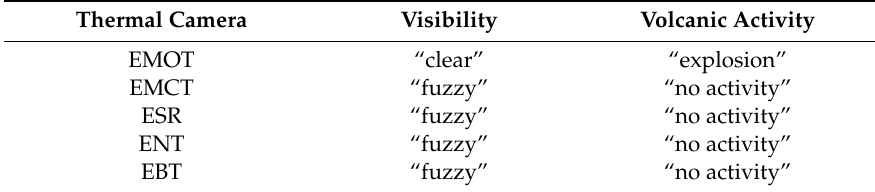
Figure 6. Raw images as acquired on 9 September, 2019 at 18:58:20 UTC by EMCT ( a ), EMOT ( b ), ESR ( c ), EBT ( d ) and ENT ( e ). The ESR camera has a lower frame rate than the others, i.e., 2 fps; for this case, the ESR image closer to the other cameras is shown. The monitored scene shows the Strombolian activity which started on the first half of September and was only just detected because of the low visibility conditions. Table 5. Algorithm Outcomes of the DT and BoW-based classifiers for the eruptive activity at NEC and VOR on 9 September, 2019.